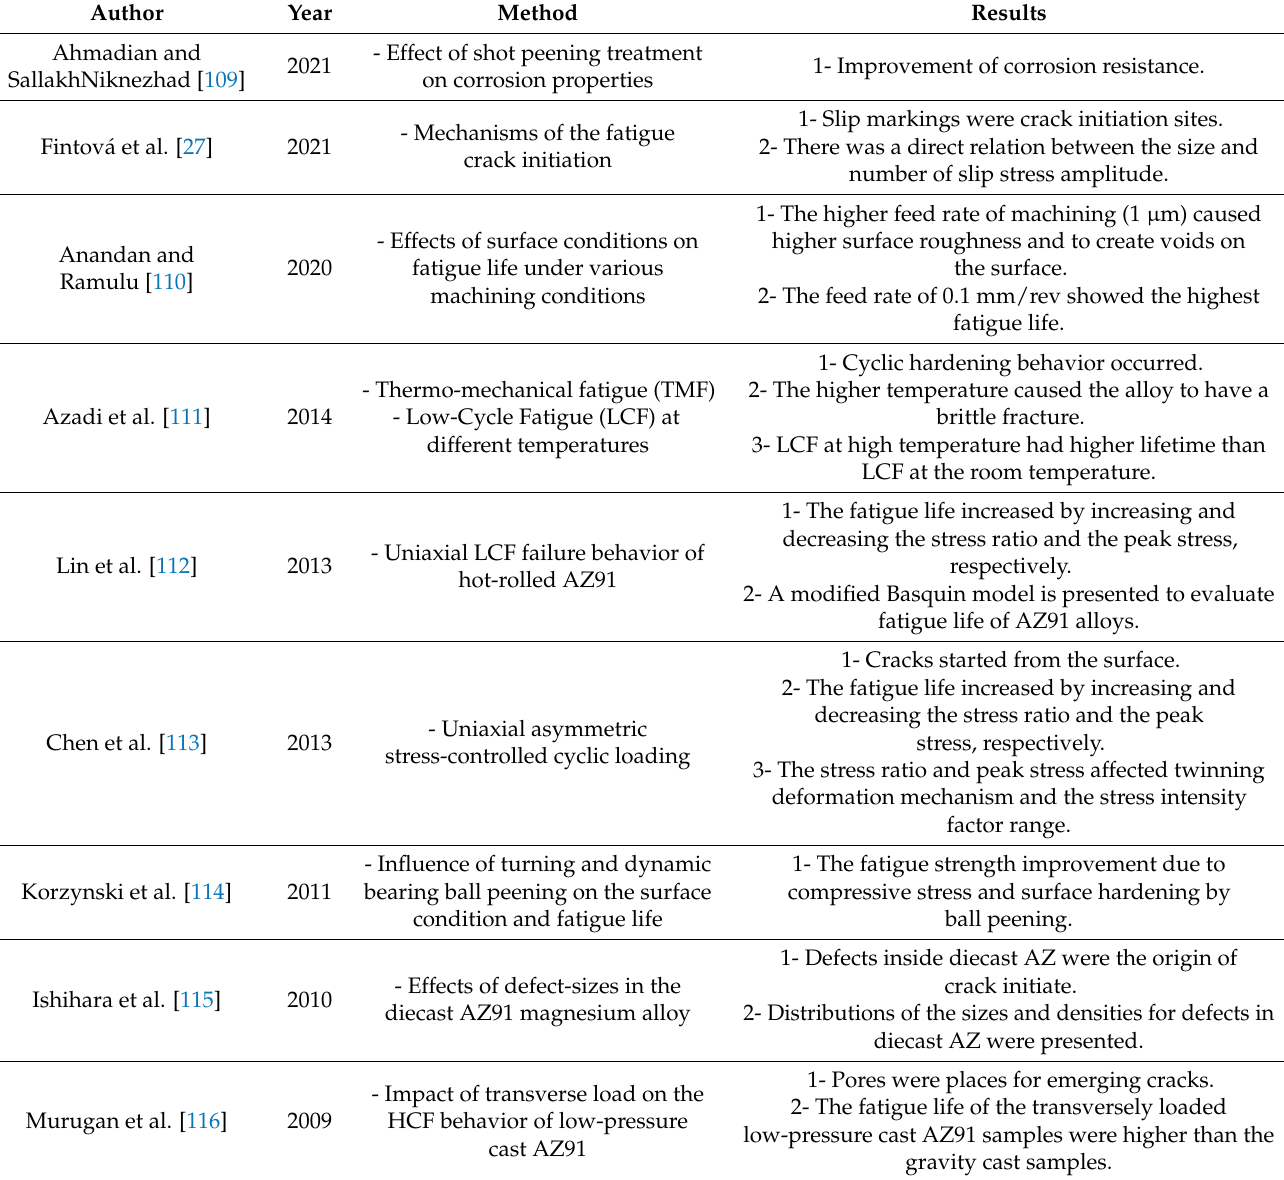
Table 11. The summary of novel research on the AZ91 magnesium